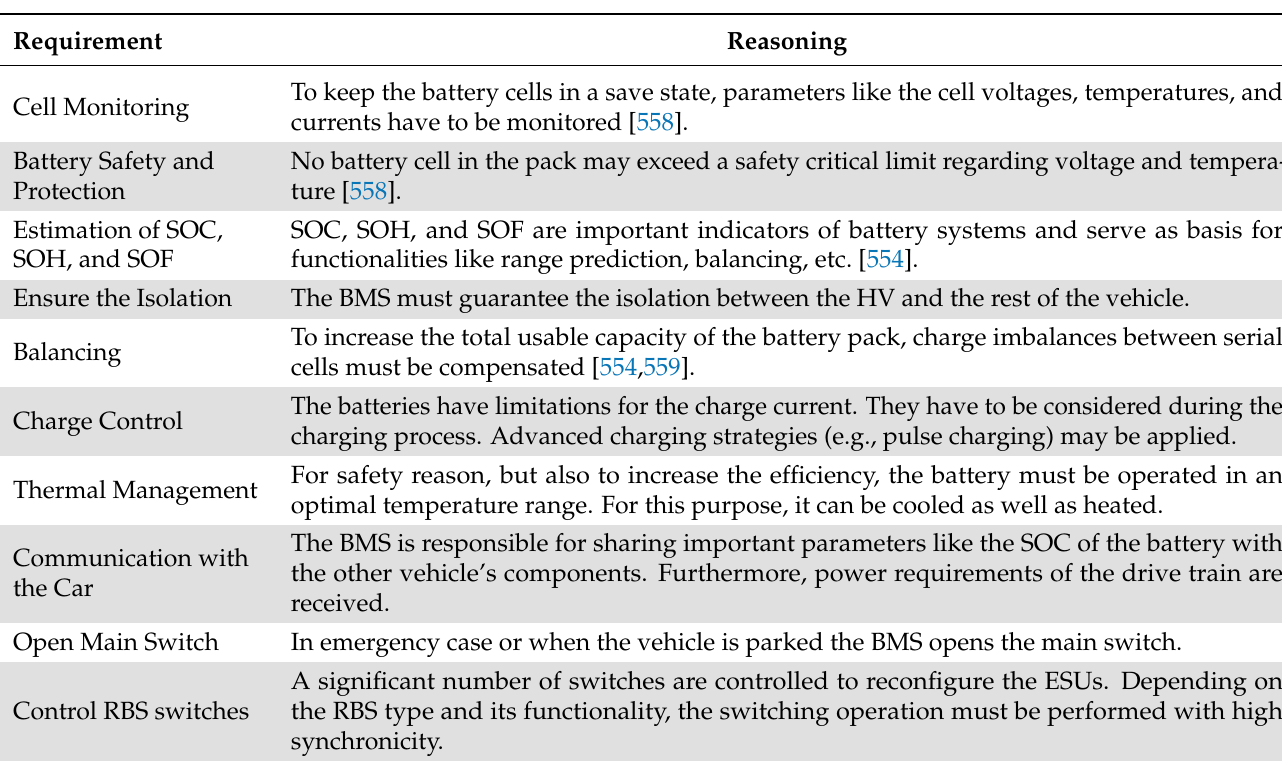
Table 9. Requirements for the BMS based on